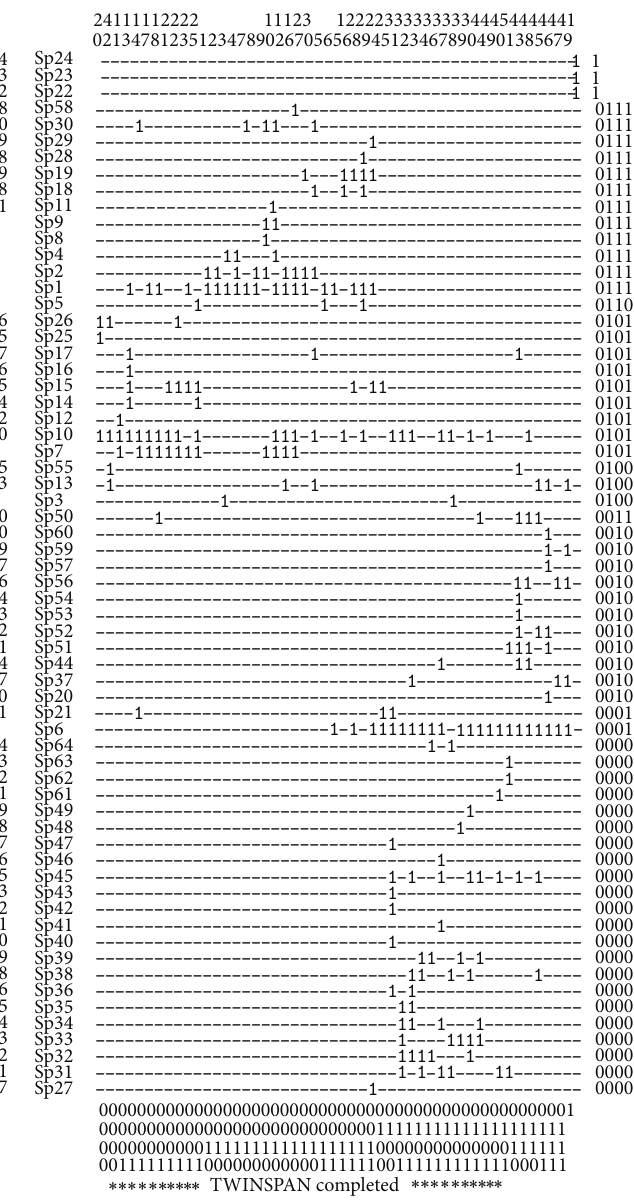
Figure 2: Twinspan analysis of 64 species and 50 plots from the foreland of Glacier-BS1, Mt. Yulong. The Sp + numbers on the left are the species code (Table 5) and the upper numbers are the plot codes. The numbers (0 and 1) on the right and bottom indicate the classification of species and